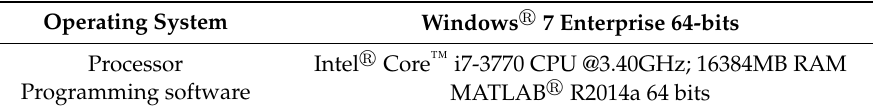
Table 3. Computer specifications.